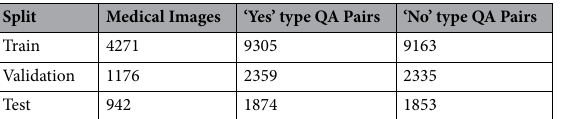
Table 3. Train, validation, and test splits for the yes-no type question-answer pairs in PathVQA